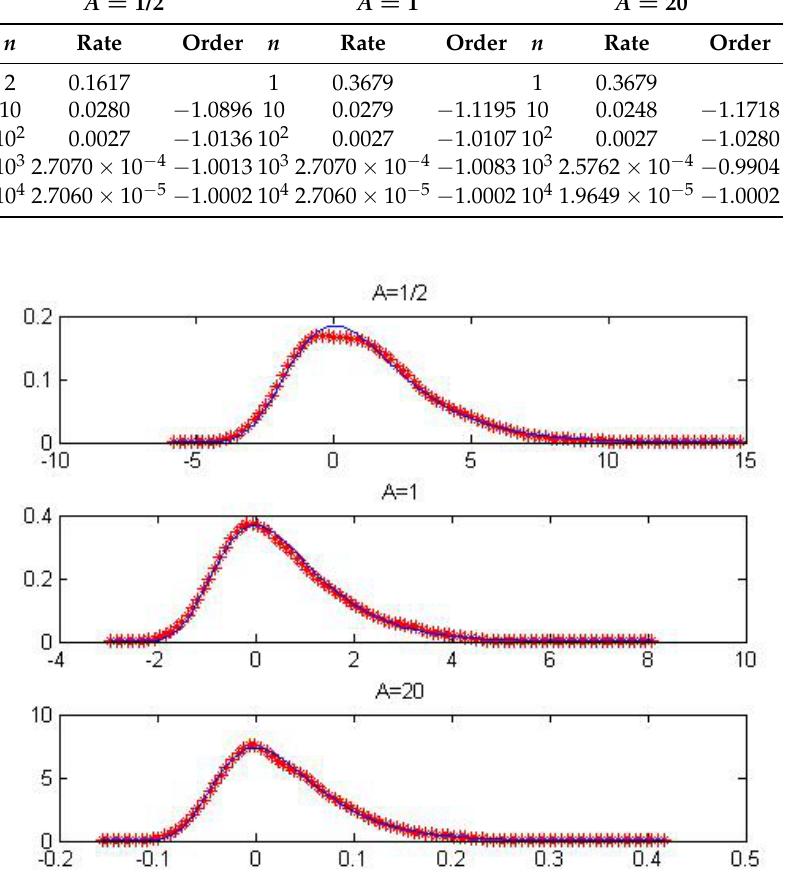
( x ) (red star) and f n ( x ) (blue line) for i.i.d. uniform A